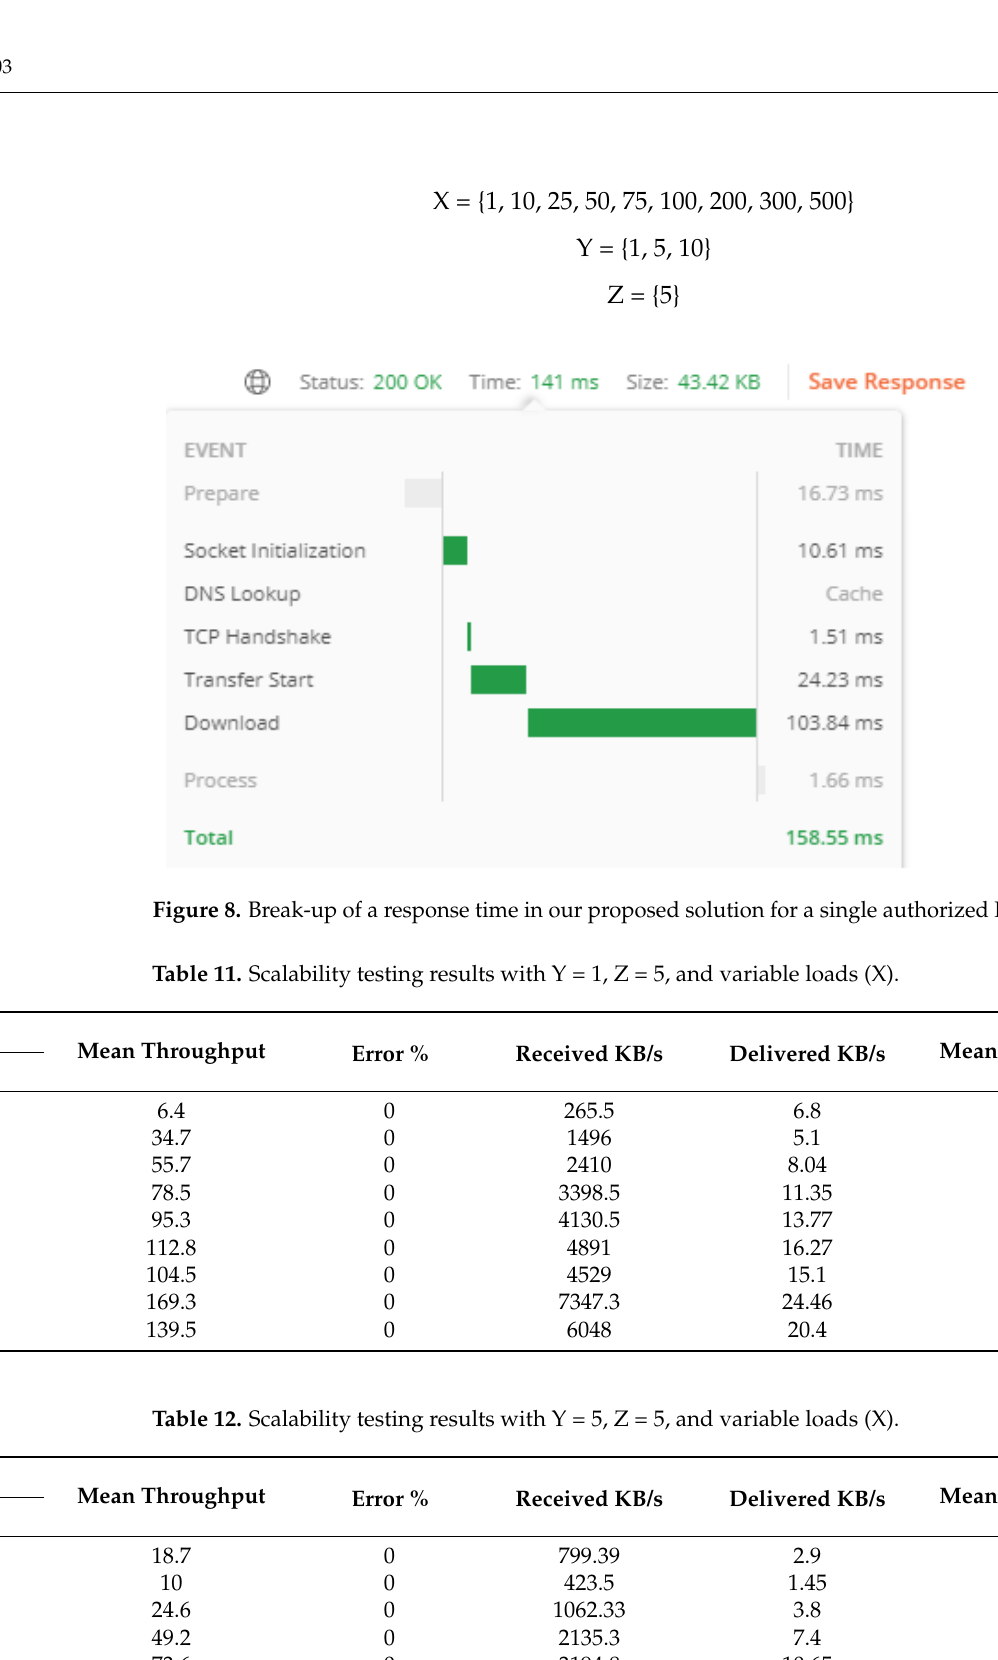
Table 12. Scalability testing results with Y = 5, Z = 5, and variable loads (X).